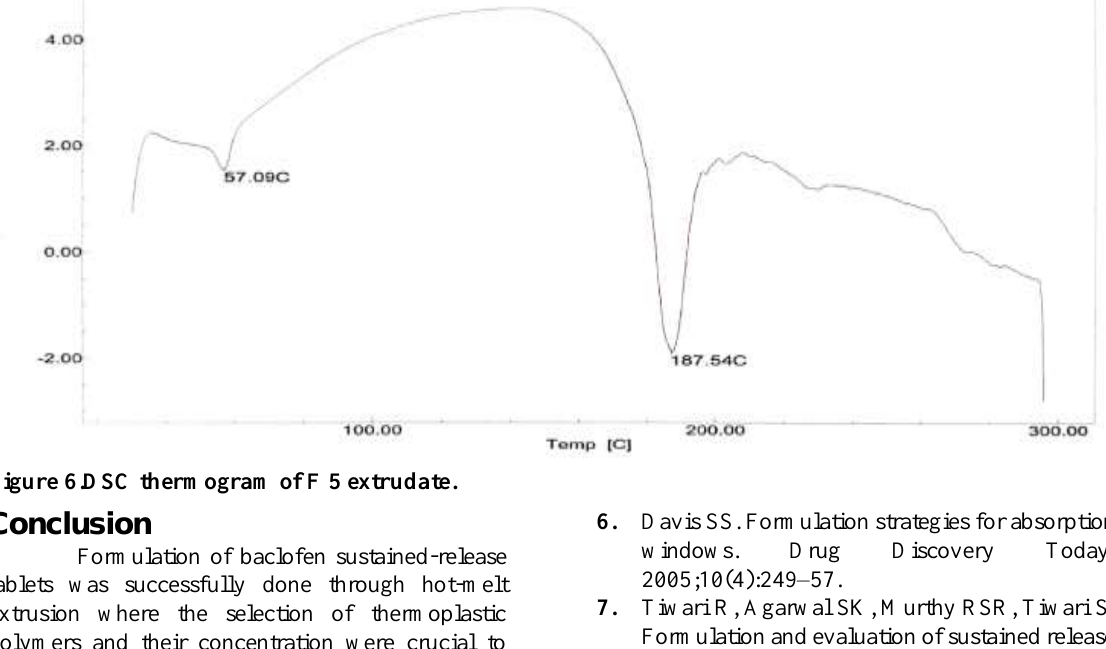
Figure 6.DSC thermogram of F 5